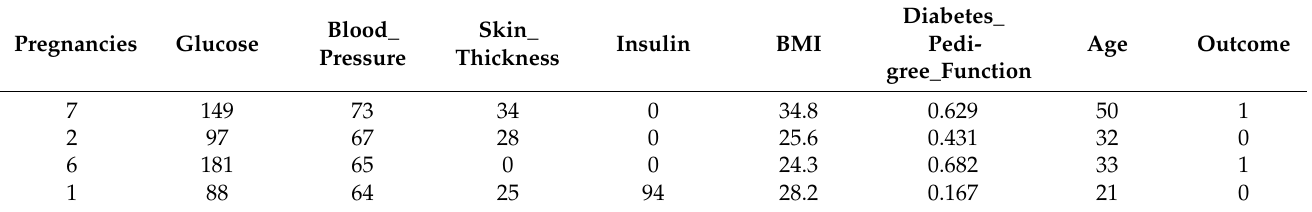
Table 4. Dataset values.